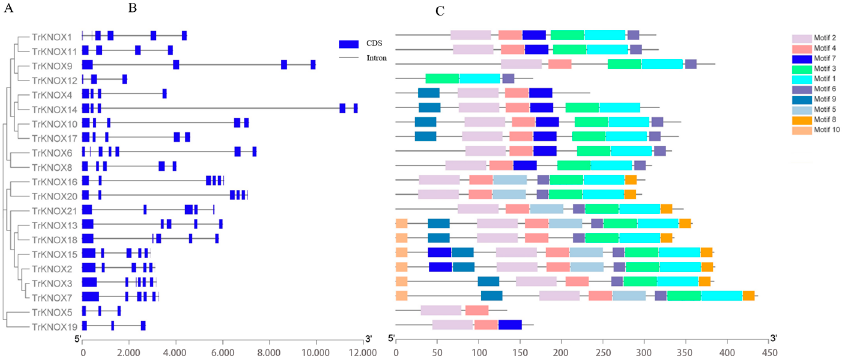
Figure 3. Gene structure and architecture of conserved protein motifs for the TrKNOX genes of Trifolium repens based on their phylogenetic relationships. ( A ) The phylogenetic tree was constructed based on the CDS sequences of T. repens KNOX family proteins by the MEGA 7 software. ( B ) CDS- intron structure of T. repens KNOX genes. Blue boxes indicate exons; black lines indicate introns. ( C ) The motif composition of TrKNOX proteins. The motifs, numbered 1–10, are displayed in different colored boxes. The sequence information for each motif is provided in Table S3. The length of the TrKNOX protein can be estimated using the scale at the bottom.